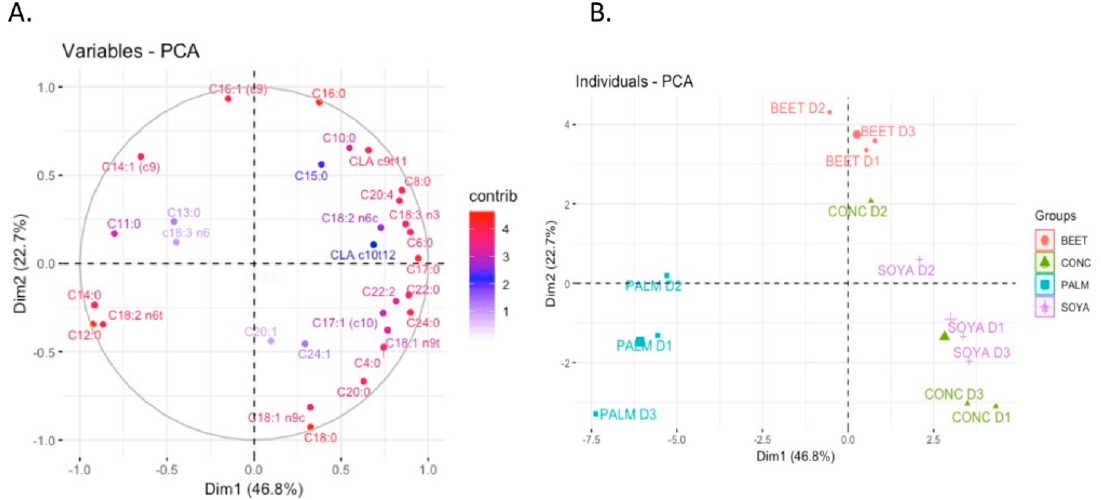
Figure 1. Principal component analysis of fatty acid methyl esthers (FAME) compounds detected from milks from each of the diets, parlour concentrate (CONC), palm kernel expeller (PALM), soya hulls (SOYA), and molassed beet pulp (BEET), principal component analysis (PCA).